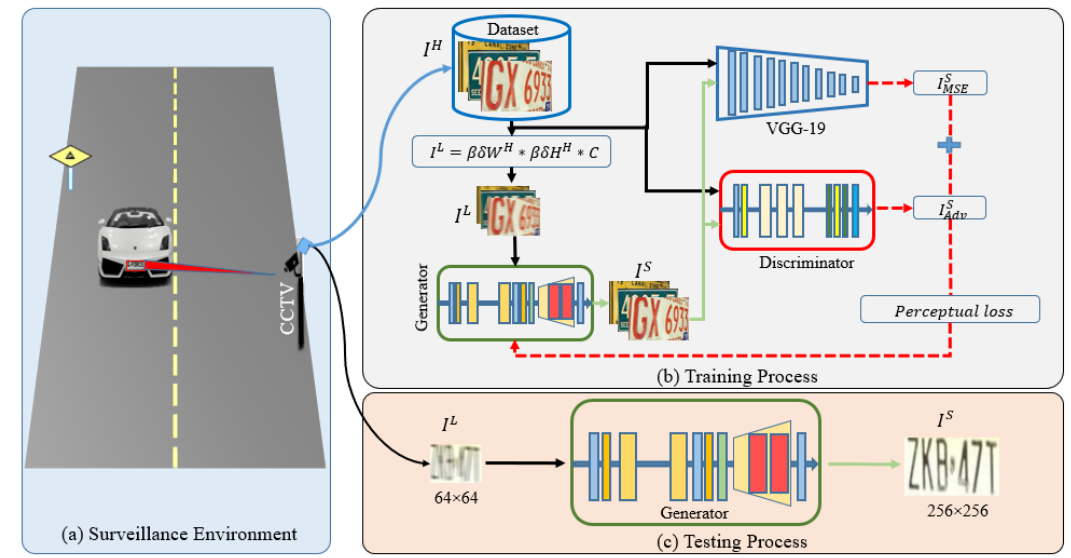
Figure 1. Overview of the proposed methodology. I H and I L are acquired from the ( a ) Surveillance environment. In the ( b ) Training process, the generator receives I L and removes blur and upscales the I L to I S . The discriminator and VGG‑19 calculate adversarial loss and content loss between the original I H and generated I S . Finally, both losses are added proportionately to form perceptual loss l S . Subsequently, l S updates the generator weights. For ( c ) Testing process, I L is directly inputted to the generator trained in the training process and I S is acquired as the resultant HR image.